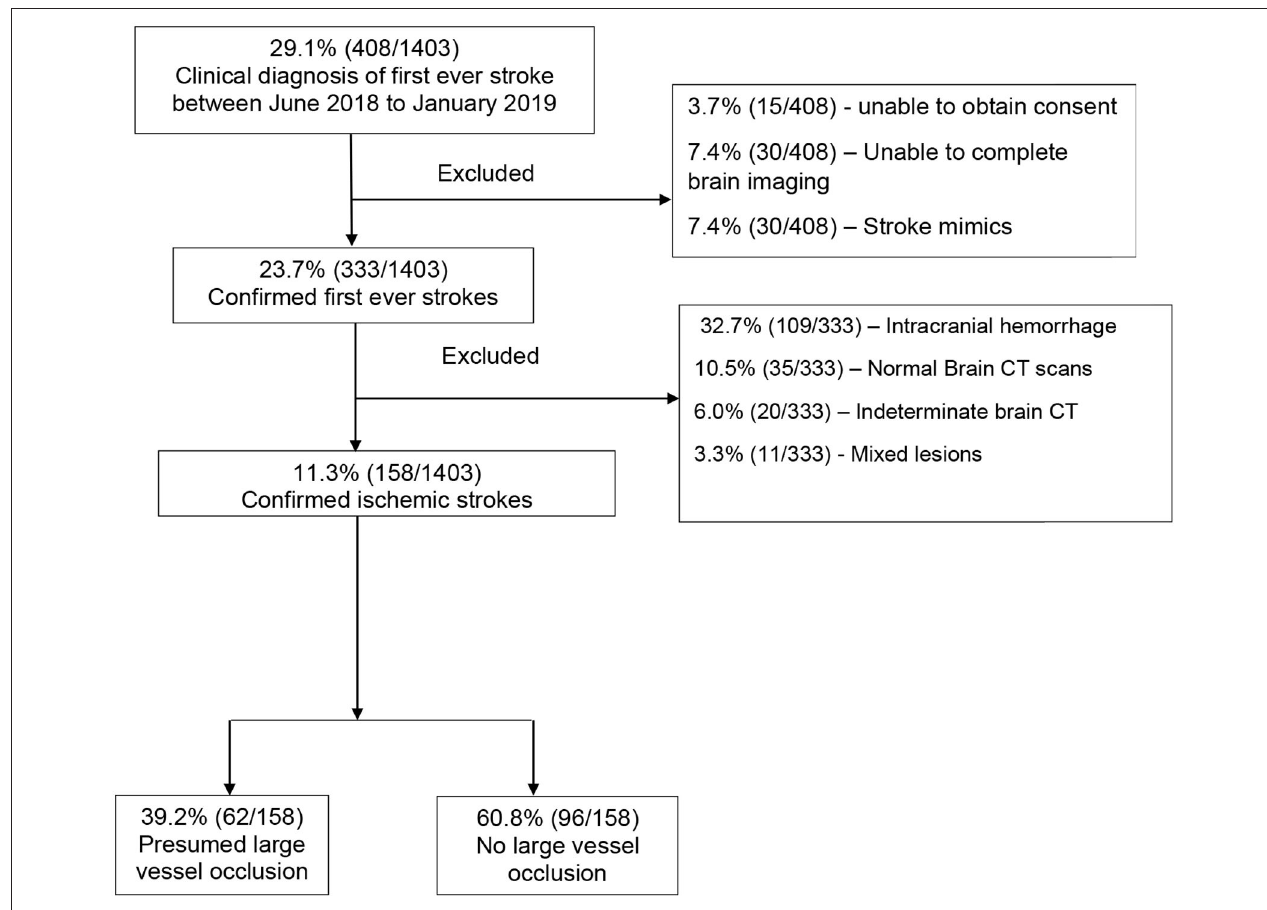
FIGURE 2 | Consort diagram showing the flow of